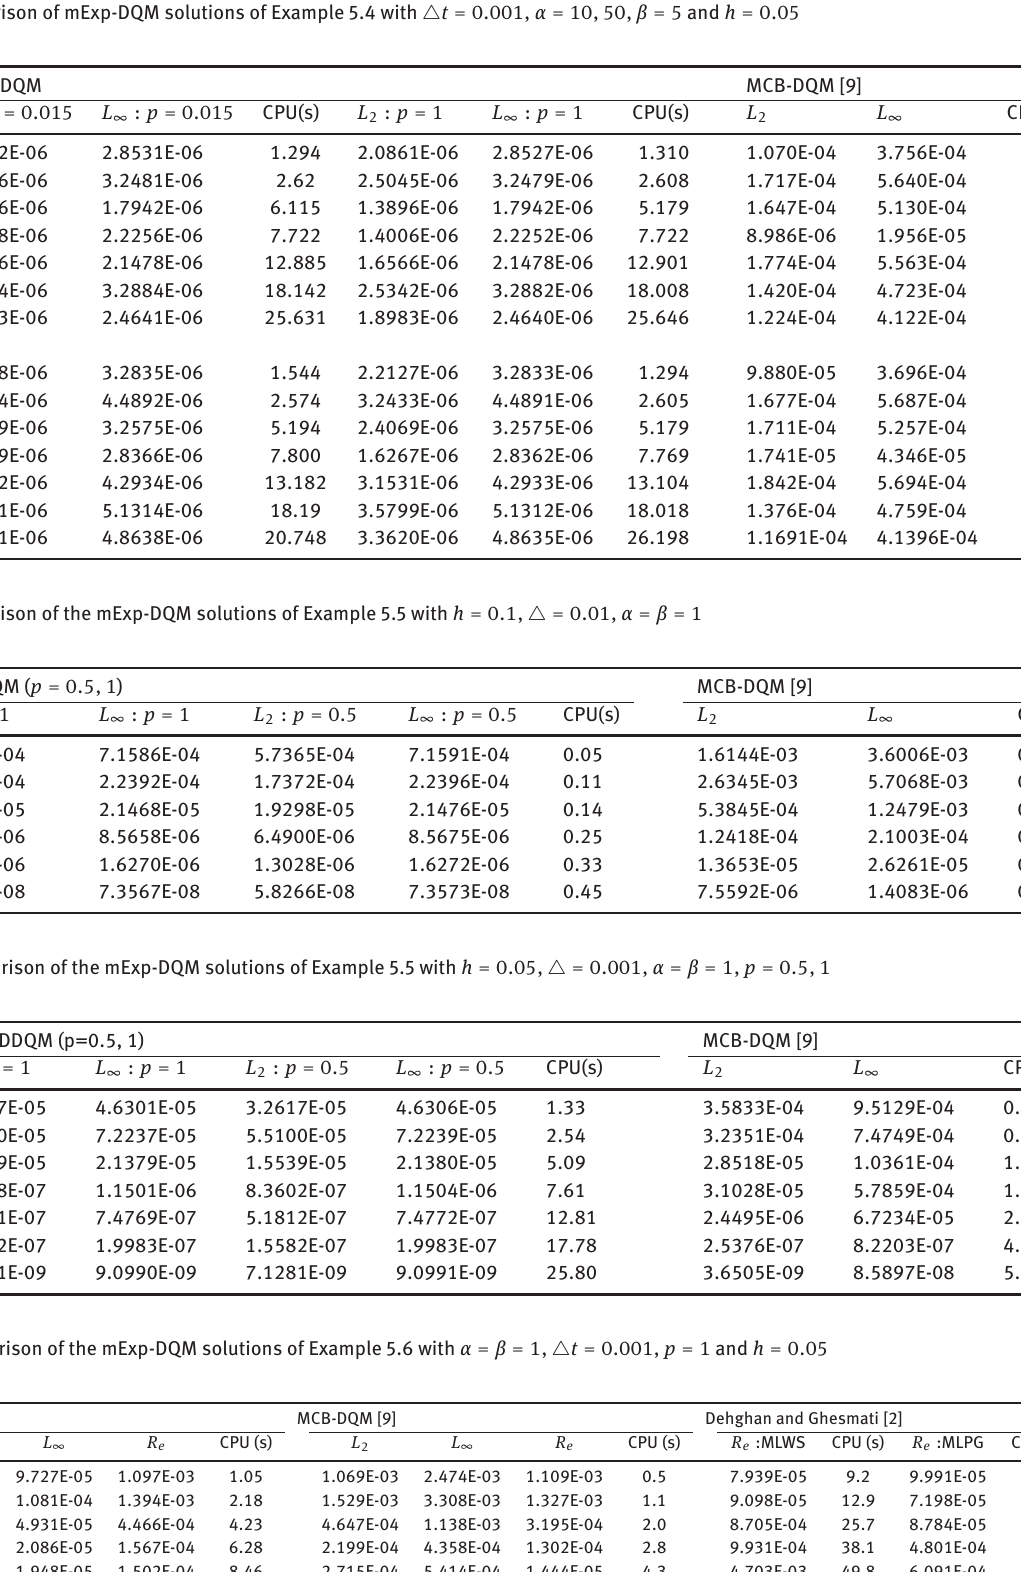
Table 8: Comparison of mExp-DQM solutions of Example 5.4 with (cid:2) t = 0.001, α = 10, 50, β = 5 and h = 0.05